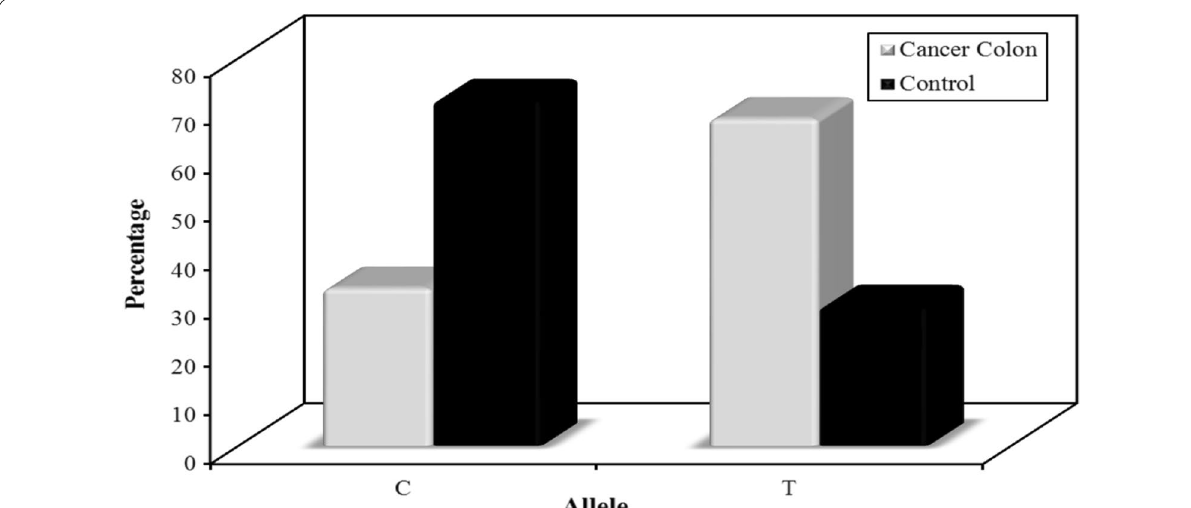
Fig. 2 Comparison between the two studied groups (colorectal cancer group (n.80) and control group (n. 80)) regarding to IGF-1 rs6214(C/T)